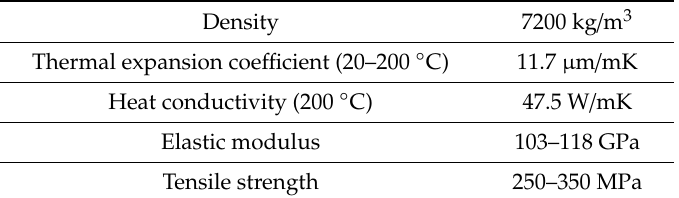
Table 1. Physical properties for grey cast iron